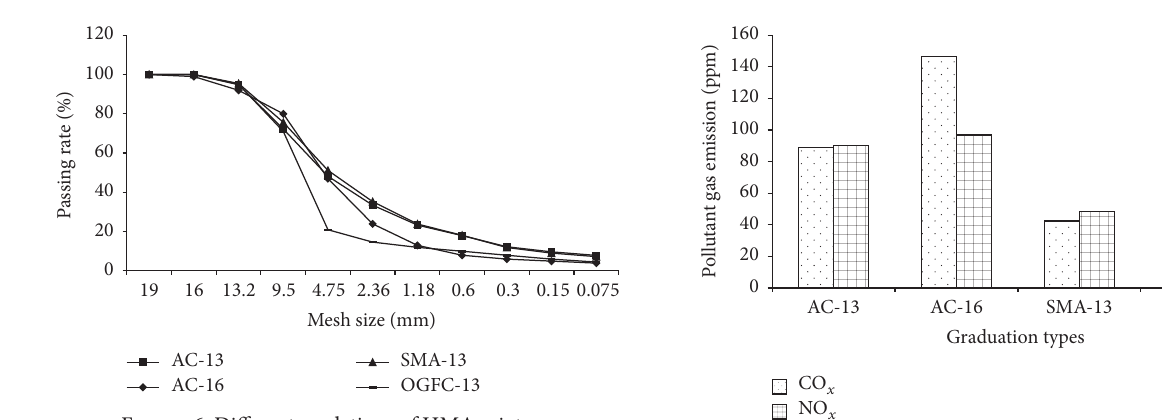
Figure 6: Different gradations of HMA mixture.